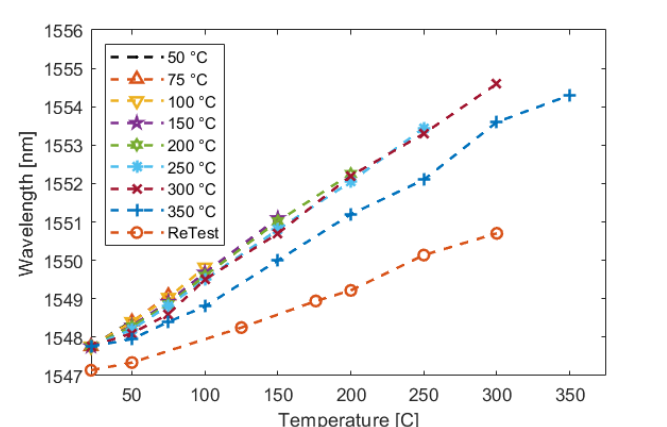
Figure 22. Elevated-temperature cyclic testing of an UAM-embedded FBG sensor. The FBG signal was measured during a cyclic temperature test with increasing oven set points. Once noticeable deviation occurred at 350 ◦ C, the test was performed one more time to confirm that permanent damage had